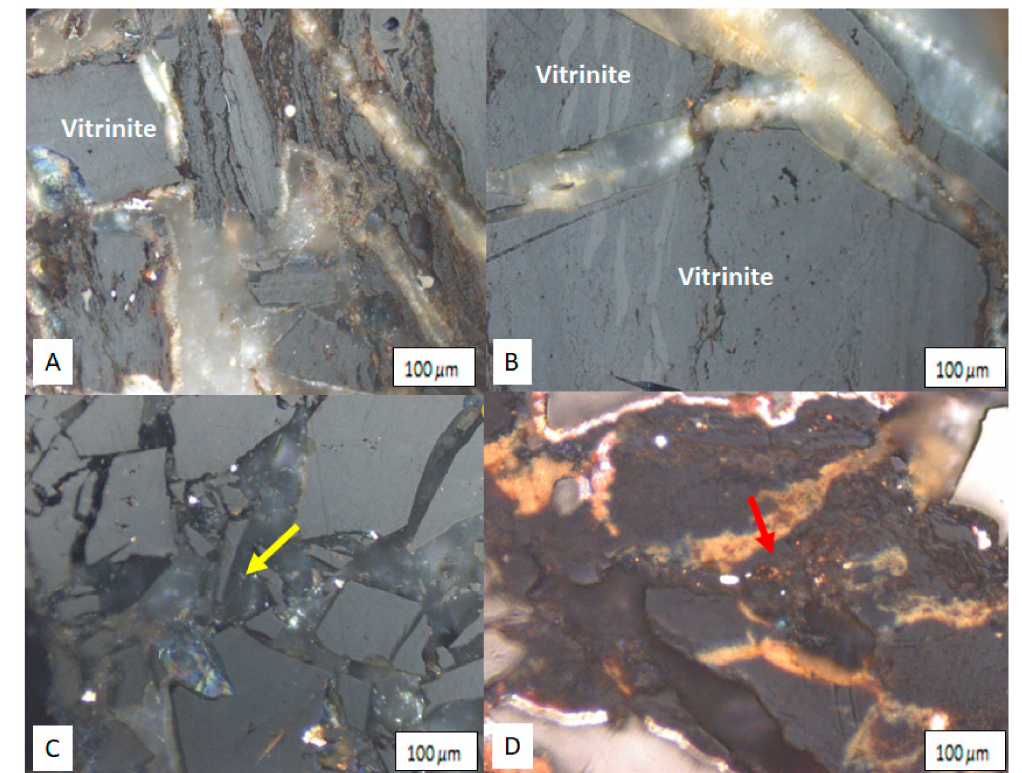
Figure 9. Photograph showing: ( A ) carbonate minerals with pyrites shattering vitrinite, with more clay minerals surrounding the shattering; ( B ) carbonate minerals with pyrites shattering vitrinite with specific example to collotelinite in darker grey shades; ( C ) carbonate mineral shattering vitrinite; and ( D ) pyrite mineral in darker